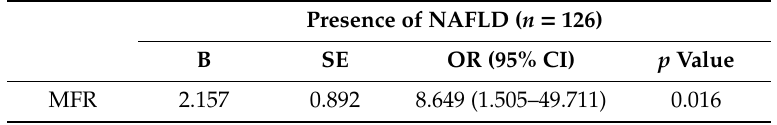
Table 3. Logistic regression analysis for the association of NAFLD with